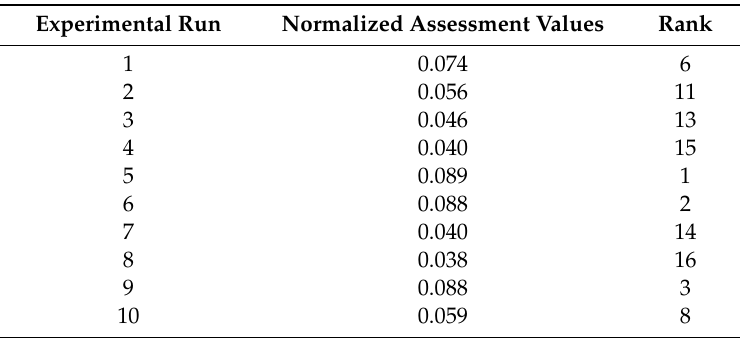
Table 8. Normalized assessment values and